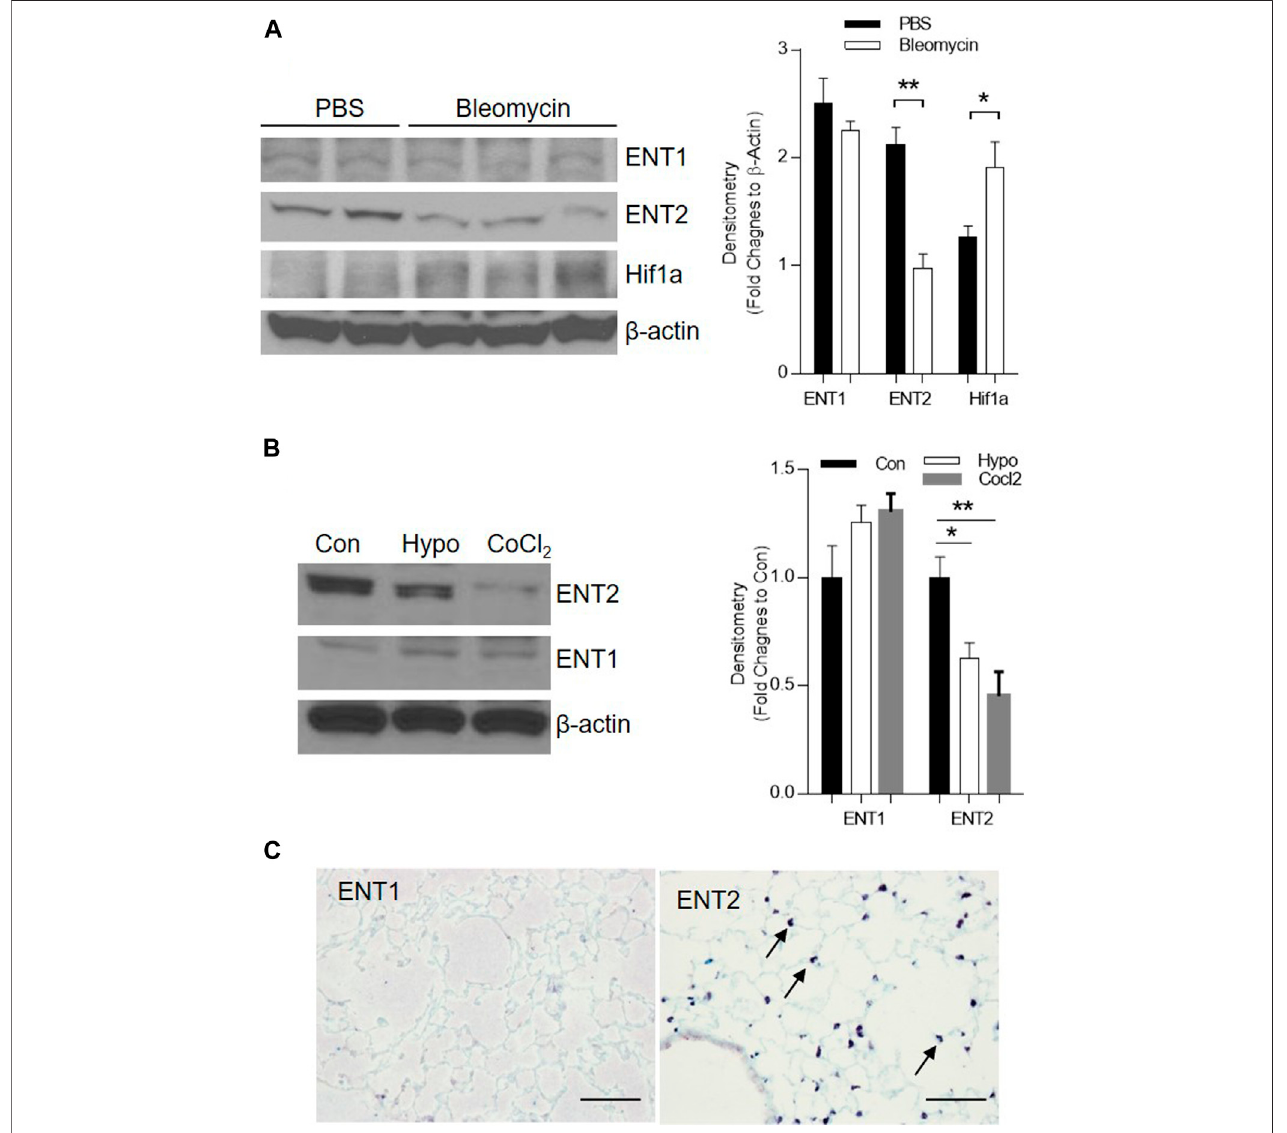
FIGURE1| ENT2expressionisdecreasedinbleomycin-inducedALI.C57BL6micewerei.t.injectedwith2.5 U/kgbleomycinandlungswerecollectedforanalysis on day 3. (A) Left Panel: The protein expression of ENT1, ENT2, and Hif1a were determined using western blot. β -Actin was used as an internal control. Right Panel: Densitometry of the Western Blot image were analyzed and data were presented as fold changes to β -Actin ± MSE. * p < 0.05, ** p < 0.01. (B) Primary alveolar epithelial type II(AECII)wereisolatedfromnormalmouselungsandexposedto2%oxygen,or100 mMCoCl 2 for24 h.RightPanel:DensitometryoftheWesternBlotimage were analyzed and data were presented as fold changes to Control (Con) ± MSE. * p < 0.05, ** p < 0.01. (C) Cellular localization of ENT1 and ENT2 (brown, arrow) was visualized using immunohistochemistry in a normal healthy mouse lung. The protein levels of ENT1, ENT2, and β -Actin were determined using western blot. n (cid:2) 3, * p < 0.05 vs. control. Scale bar (cid:2) 100 µm.